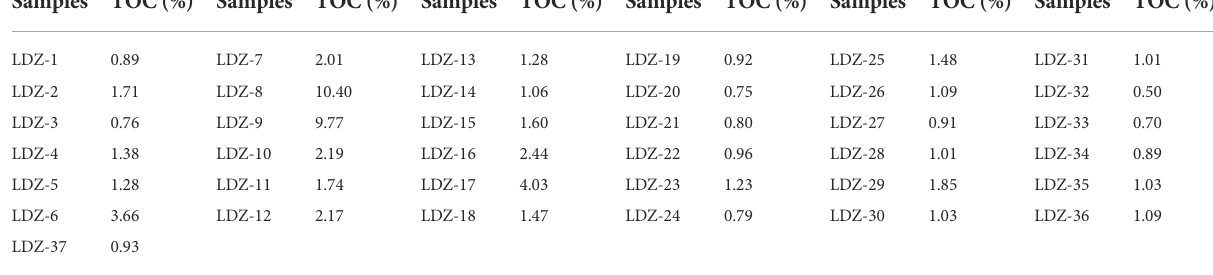
TABLE 4 TOC content result of Jiusi Formation in